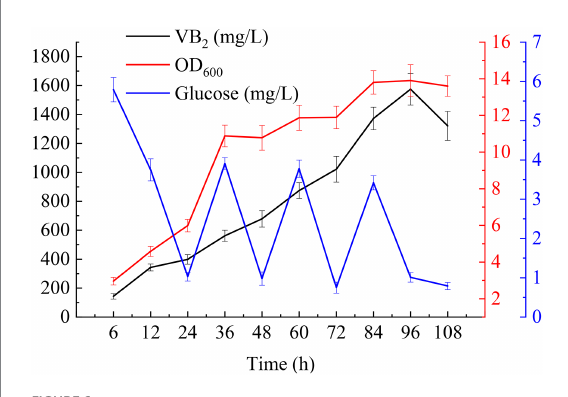
FIGURE 6 Time-course profiles of key fermentation parameters: glucose concentration, OD 600, and RF titer in MSY medium during fed- batch